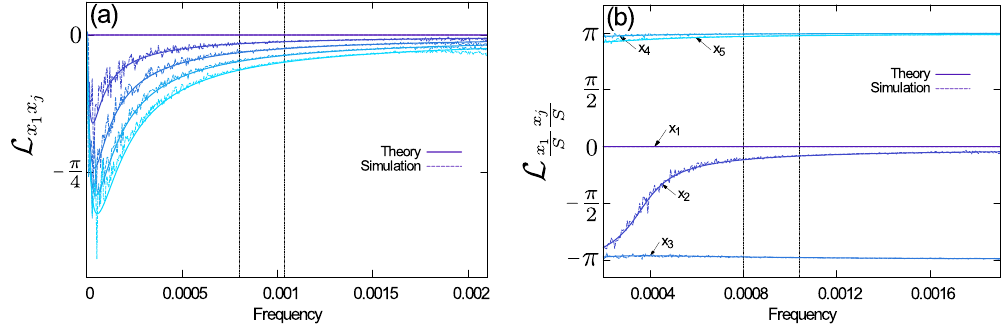
Figure 9. Phase-lag of time series between different subgroups of susceptibles. Data is for the same setup as in Fig. 7. We show the phase-lag between subgroups i and reference subgroup 1. Panel (a) depicts the case in which time series are normalized with respect to the total population, N ; in panel (b) input time series are normalized with respect to the total number of susceptibles NS . As in Fig. 8, the vertical dotted lines mark the half-width of the peaks in the corresponding power